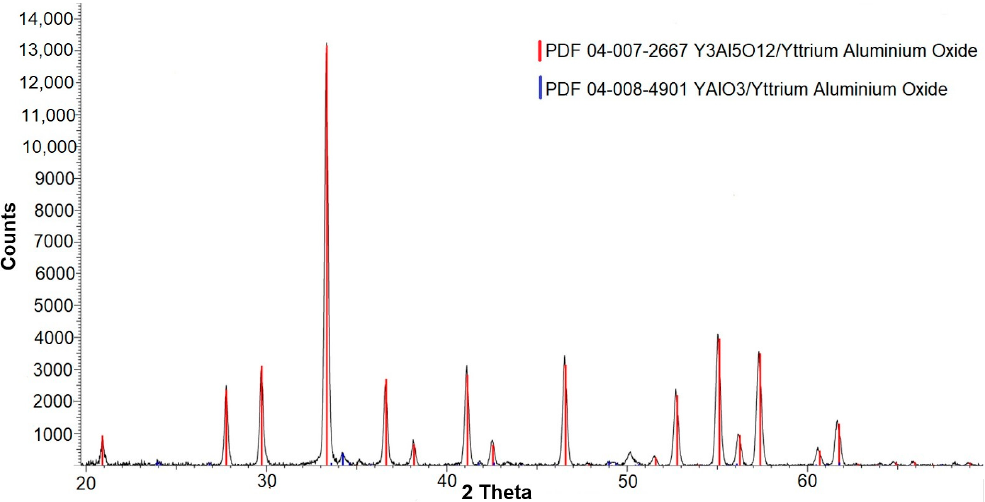
Figure 3. X-ray di ff raction spectra of YAG:Eu (8%). Figure 3. X-ray diffraction spectra of YAG:Eu